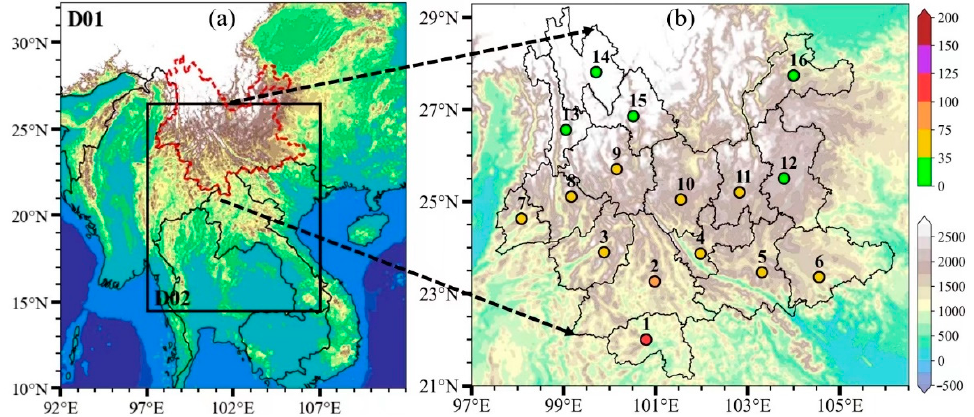
Figure 1. ( a ) Two nesting domains of WRF-Chem modeling with the terrain heights (m in a.s.l.) over the YP (outlined with dash red line) and surrounding regions in southwest China and Southeast Asia. ( b ) Spatial distribution of averaged surface PM 2.5 concentrations (color shaded circles with black edges, µ g m − 3 in the upper color bar) observed at 16 urban sites (Table 2) from 24 to 26 March 2017 over YP, and spatial distribution of topographic height over YP and surrounding areas (color contours, m in a.s.l. in the lower color